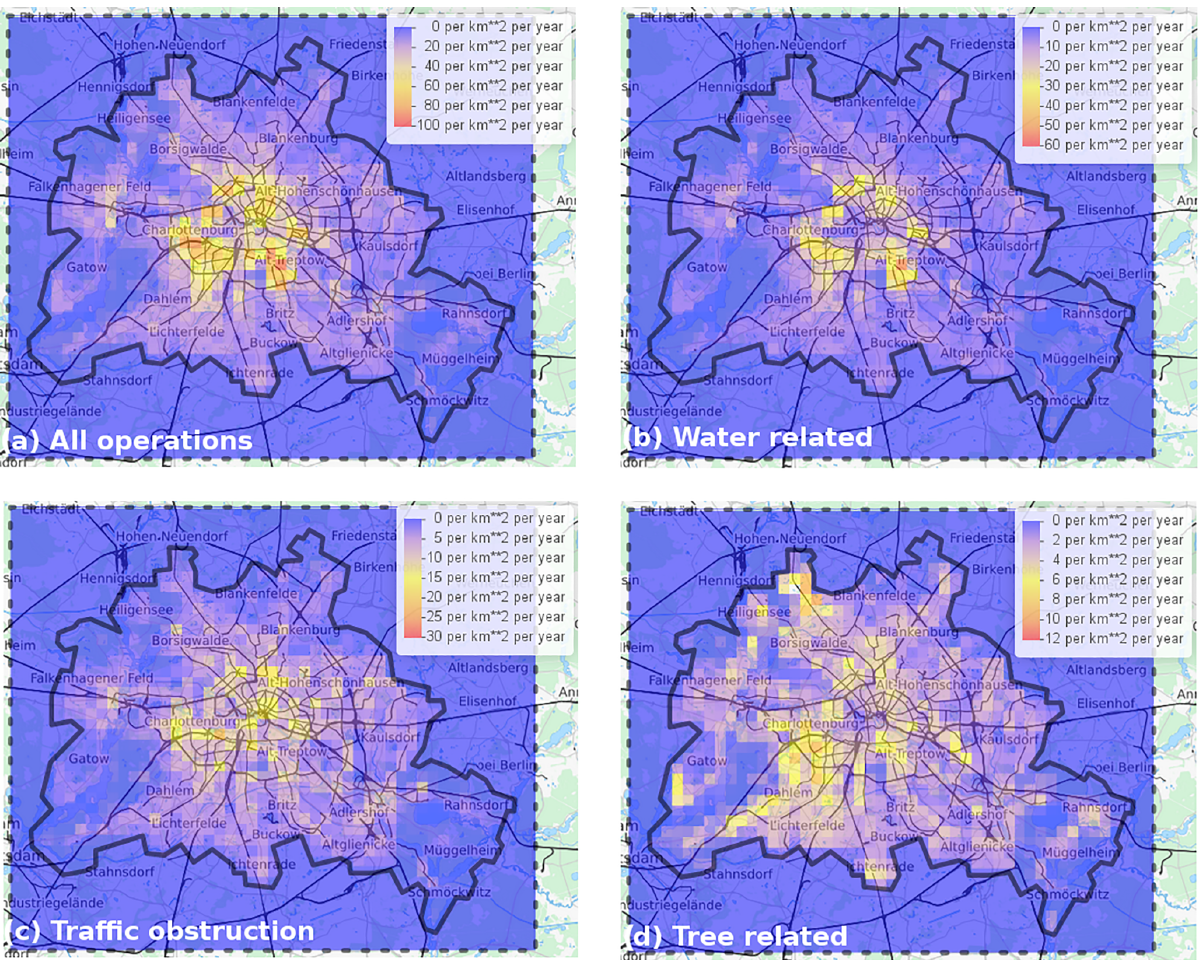
Figure 2. Mean yearly density of fire brigade operations during 2002–2011 calculated on a 1 × 1km grid (units: operations per square kilometre per year). Operation recordings are available for Berlin only (boundaries are indicated by black solid lines); i.e. zero values outside of Berlin are due to unavailability of data. Note the different colouring scale due to the fact that the absolute numbers of operations for a certain operation type vary